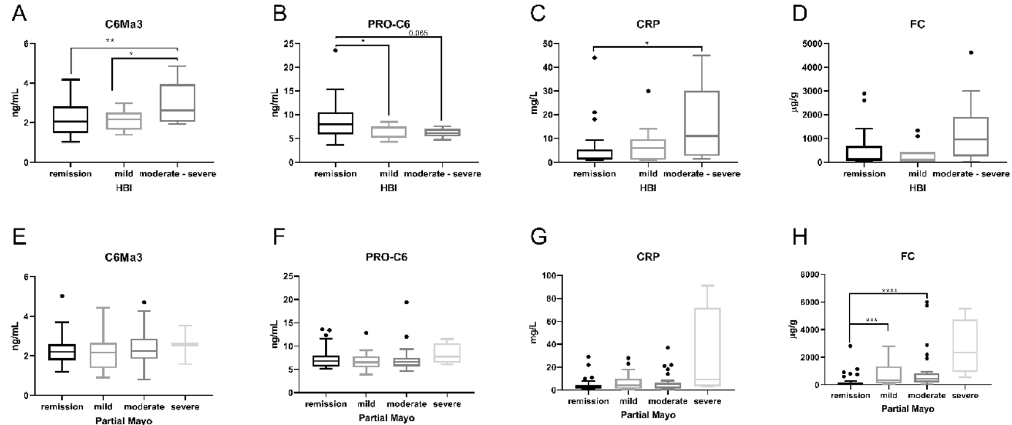
Figure 1. Levels of the biomarkers C6Ma3 ( A , E ), PRO-C6 ( B , F ), CRP ( C , G ), and FC ( D , H ) in CD and UC patients grouped by the clinical scoring indexes HBI and Mayo partial. Ordinary one-way ANOVA with Tukey’s multiple comparisons test and Kruskal–Wallis tests with Dunn’s test for multiple comparison were used were applied. *p < 0.05, **p < 0.01, ***p < 0.001, ****p < 0.0001.